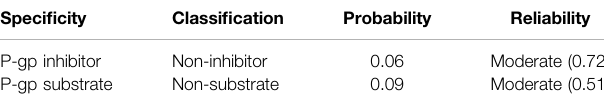
TABLE 2 | In Silico P-glycoprotein (P-gp) speci fi city of paeonol. Speci fi city